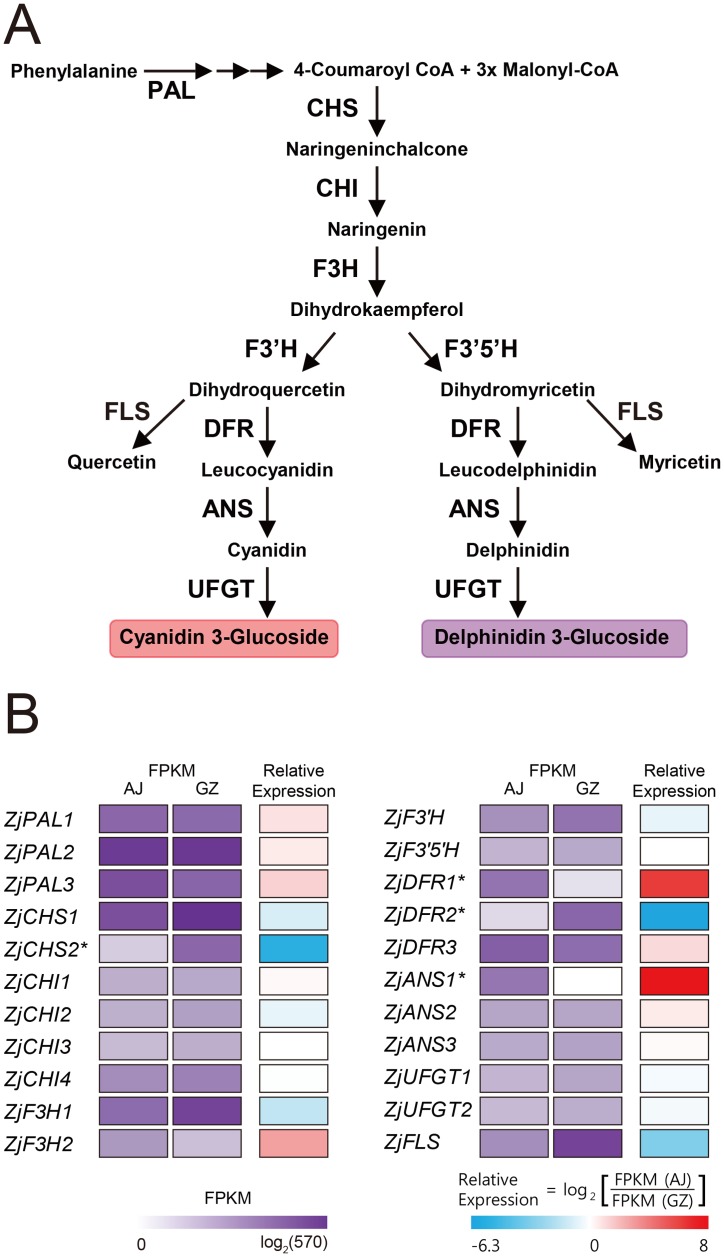
Zoysiagrass transcripts involved in general anthocyanin biosynthesis pathway.(A) A schematic view of the core anthocyanin biosynthesis pathway. ANS, anthocyanidin synthase; CHS, chalcone synthase; DFR, dihydroflavonol reductase; F3H, flavanone 3-hydroxylase; F3’H, flavonol 3’-hydroxylase; F3’5’H, flavonol 3’,5’-hydroxylase; FLS, flavonol synthase; PAL, phenylalanine ammonia lyase; UFGT, UDP-glucose:flavonoid 3-O-glucosyltransferase. (B) Heatmap of digital expression of candidate transcripts related to anthocyanin biosynthesis pathway in zoysiagrass. The log2-transformed FPKM values and relative expression (AJ vs. GZ) values are represented by the color map. Asterisks indicate statistical DEGs.